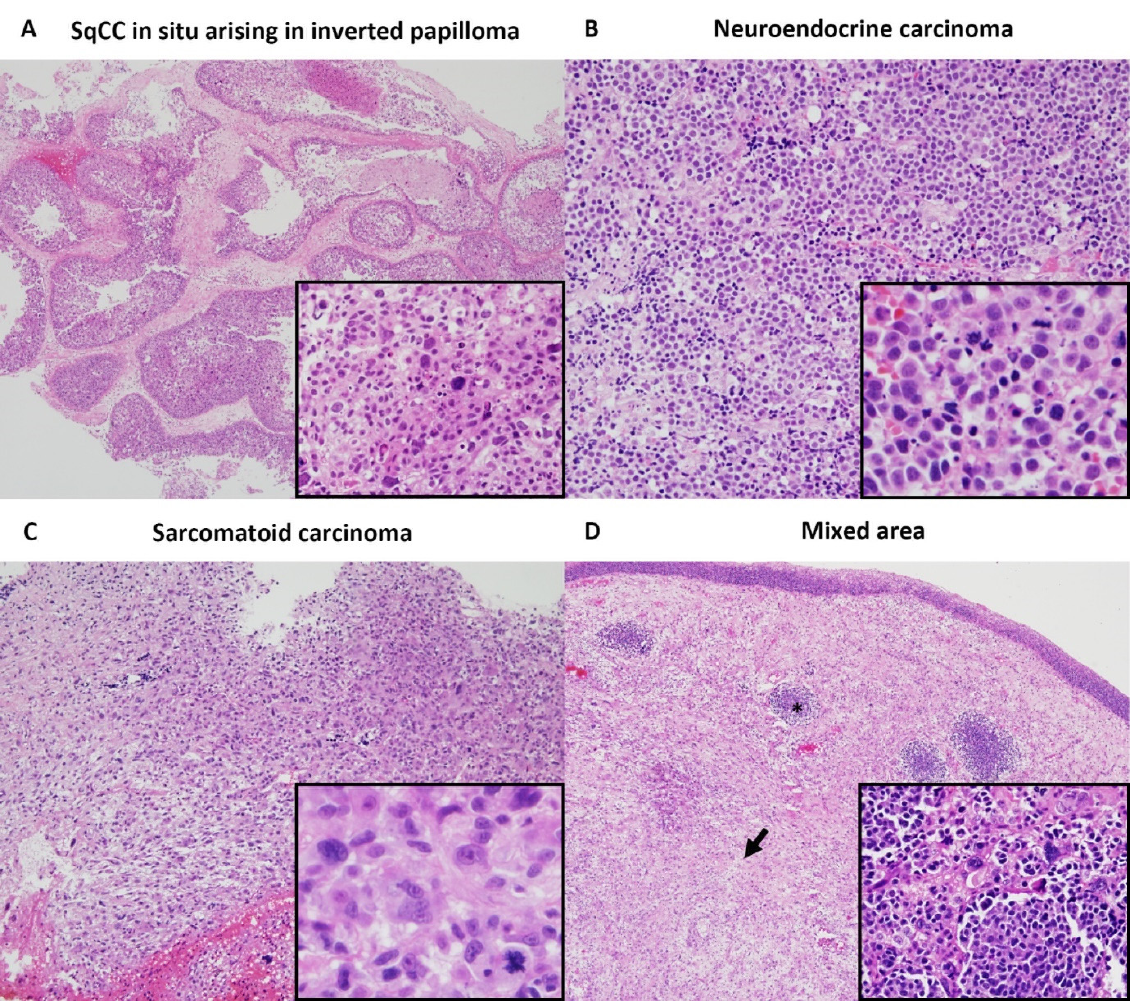
Figure 2. Endoscopic excisional biopsy of the right nasal cavity mass was performed. The tumor was found to consist of three morphologically distinct components in the resected specimen. These components were partly clearly separated and partly strictly mixed. ( A ) The first component was SqCCis arising in inverted papilloma, which represented approximately 20% of the lesion. ( B ) The second component comprised of nests of closely packed, small round to atypical oval cells, with hyperchromatic nuclei, coarse chromatin, and scant pale eosinophilic cytoplasm. The tumor had karyorrhectic debris and mitotic activity. ( C ) This represented about 40% of the lesion. The third component consisted of a solid sheet of anaplastic spindle cells proliferation with prominent mitosis and multinucleated giant cells, which represented the remaining 40% of the lesion. ( D ) Of note, the focal area showed a tumor with admixed small round cell nests and anaplastic spindle cell elements overlying SqCCis. Asterisk, small round cell nest; arrow, spindle cell proliferation; right upper, squamous cell carcinoma in situ. The original magnifications were 40× and 400× in the inset